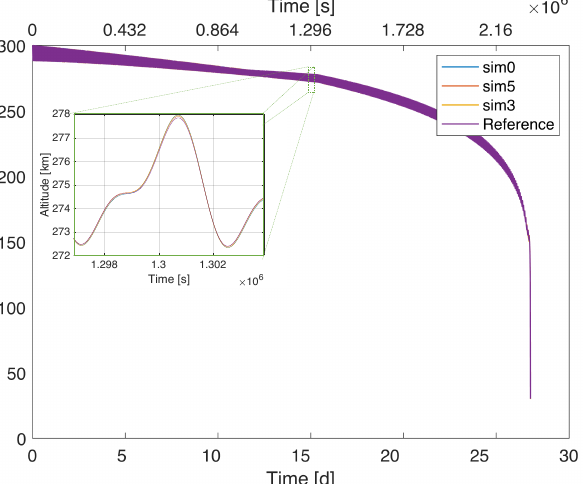
Figure 10. Actual and reference trajectory comparison. The bottom axis displays the time scale in days, while the upper axis shows it in seconds. The zoomed-in detail of the de-orbiting path shows the overlapping of the different